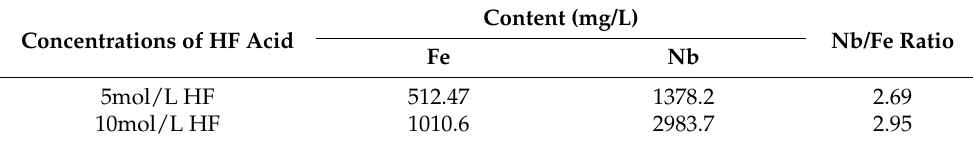
Table 3. ICP detection results of the solution of different concentrations of HF acid leaching minerals.